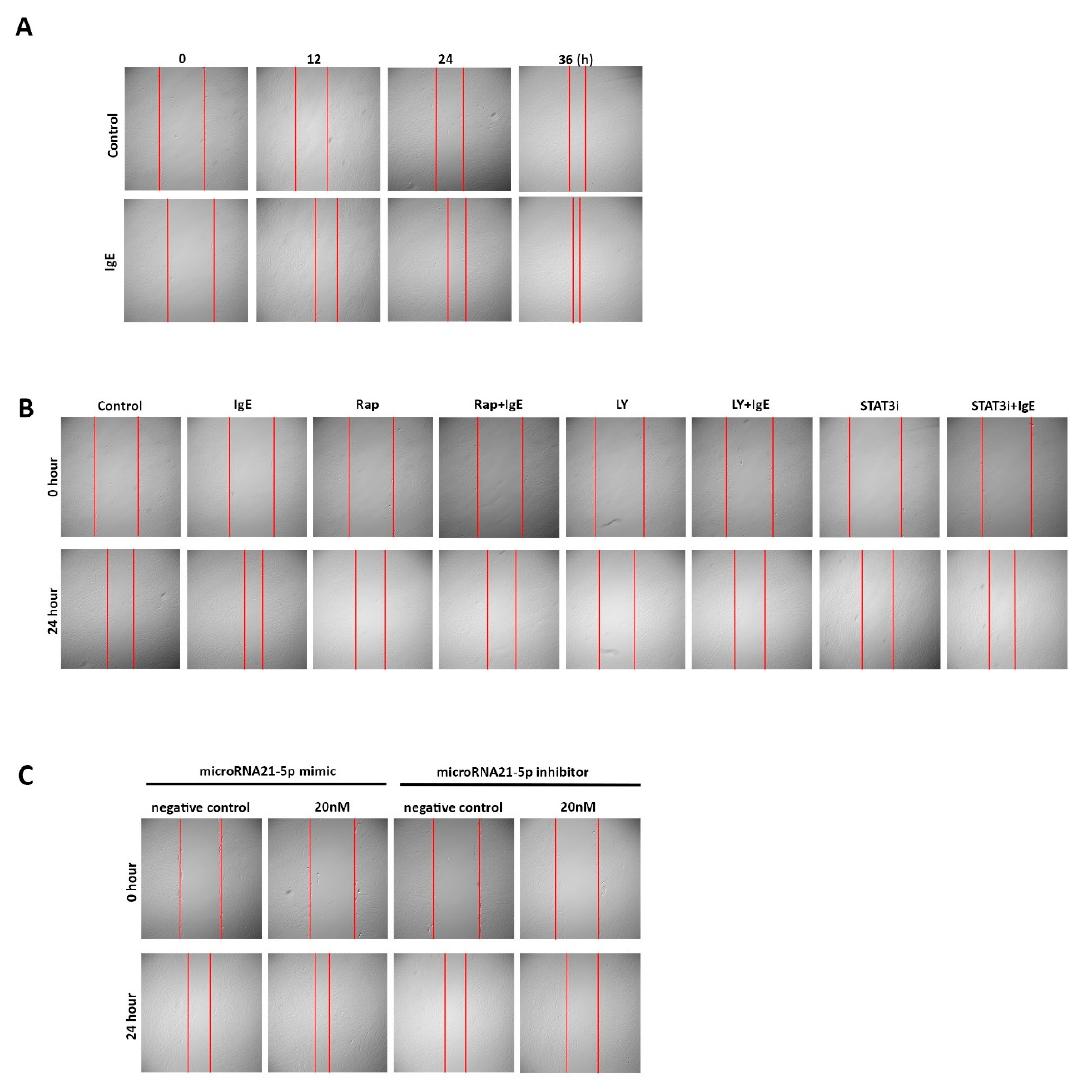
Figure A1. Representative microscopic images of ASMC migration into a denuded area (wound repair). ( A ) Kinetic of ASMC migration. ( B ) ASMC migration in the presence of either IgE or different signaling inhibitors after 24 h. ( C ) ASMC migration in the presence of IgE and microRNA-21-5p mimics or inhibitors.